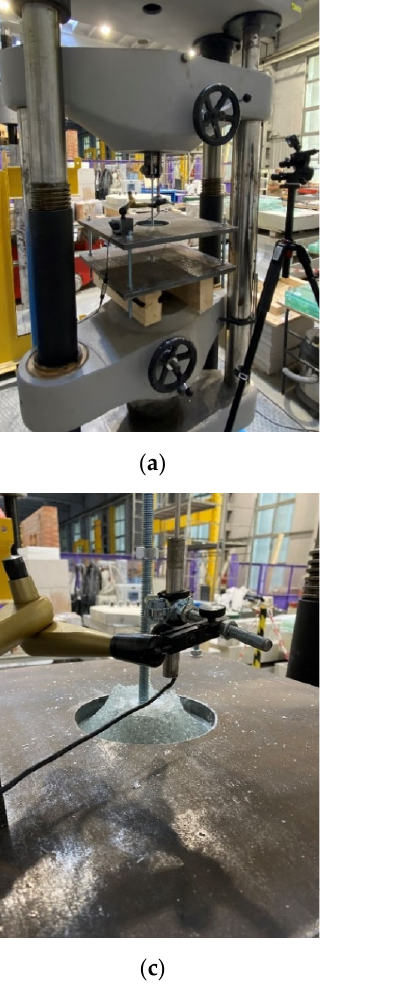
Figure 6. Experiments: ( a ) test setup; ( b ) deformation of the sample in the post ‐ breakage state (view from below the fixed base); ( c ) deformation of the sample in the post ‐ breakage state (view from below the fixed base); ( d ) end of experiment (ultimate failure).